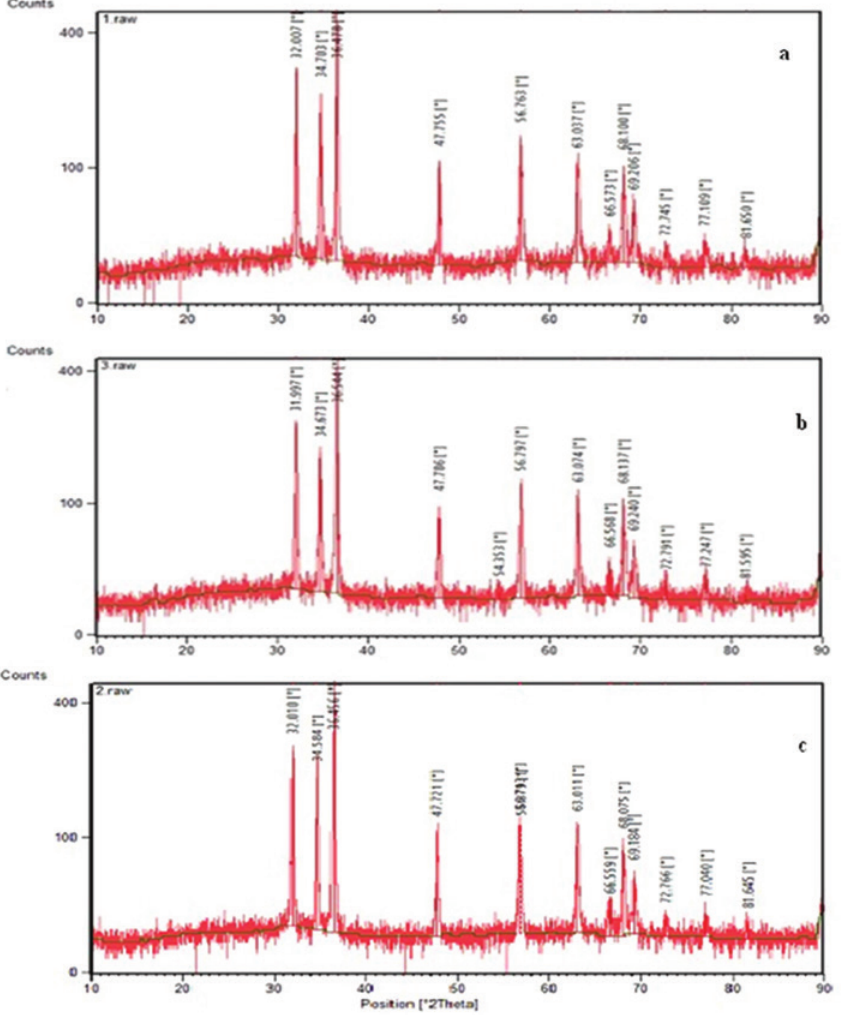
Figure 2: XRD pattern of the fabricated ZnO NPs using Pelargonium leaf extract and three different methods namely conventional heating (heater-stirrer) (A), autoclave (B), and microwave irradiation